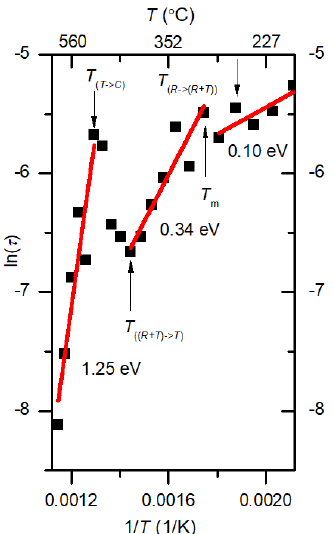
Fig. 14 Dependence of the relaxation time of NBT ceramics, calculated from the modulus spectrum ( M'' vs. frequency) for peak A (grain boundary), on 1/ T . The arrows show the temperatures at which crystal symmetry changes upon heating. R , T , ( R + T ), and C denote rhombohedral, tetragonal, coexisting rhombohedral and tetragonal phases, and cubic symmetry,